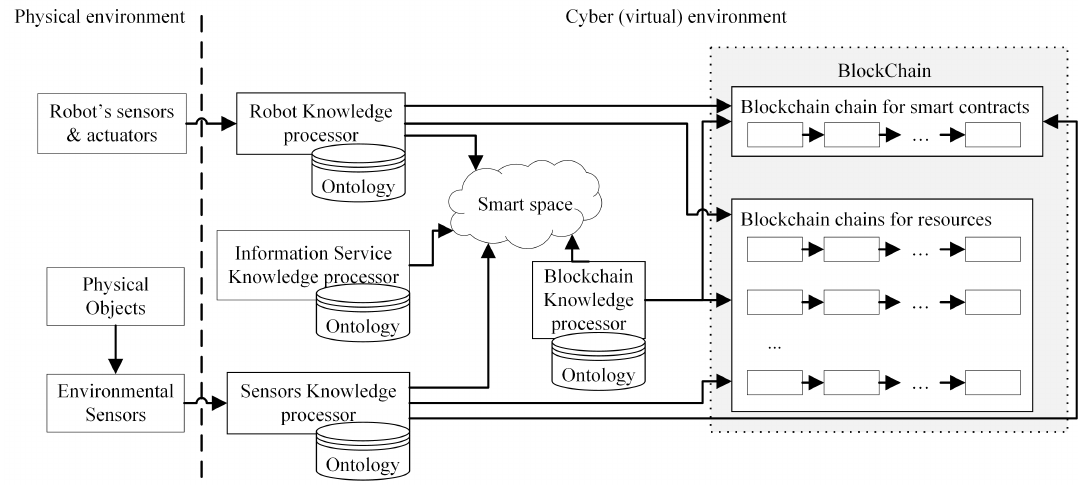
Figure 4. Framework for robot coalition